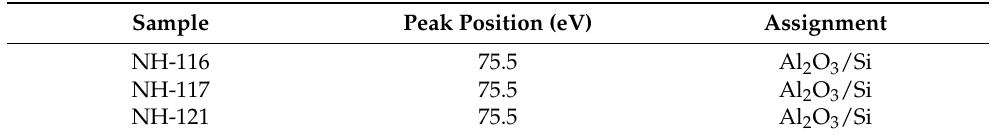
Table 3. Al 2p peak positions and their assignments for the different aluminum species found in the samples. Sample